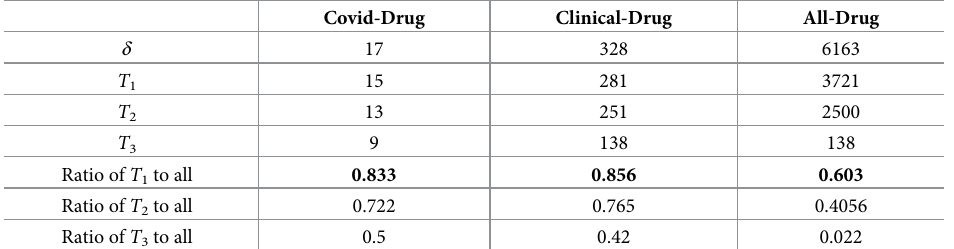
Table 5. The number of drugs in each candidate set for All-drug, Clinical-Drug, and Covid-Drug groups reported in the four first rows. The rate of the number of drugs presented in the second, third, and fourth rows to the total number of drugs in each group reported in the fifth, sixth, and seventh rows respectively.